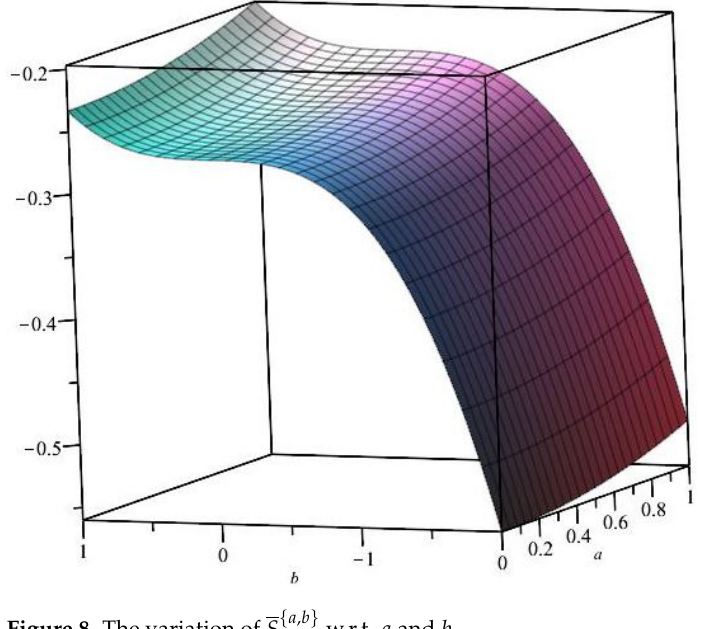
Figure 8. The variation of S